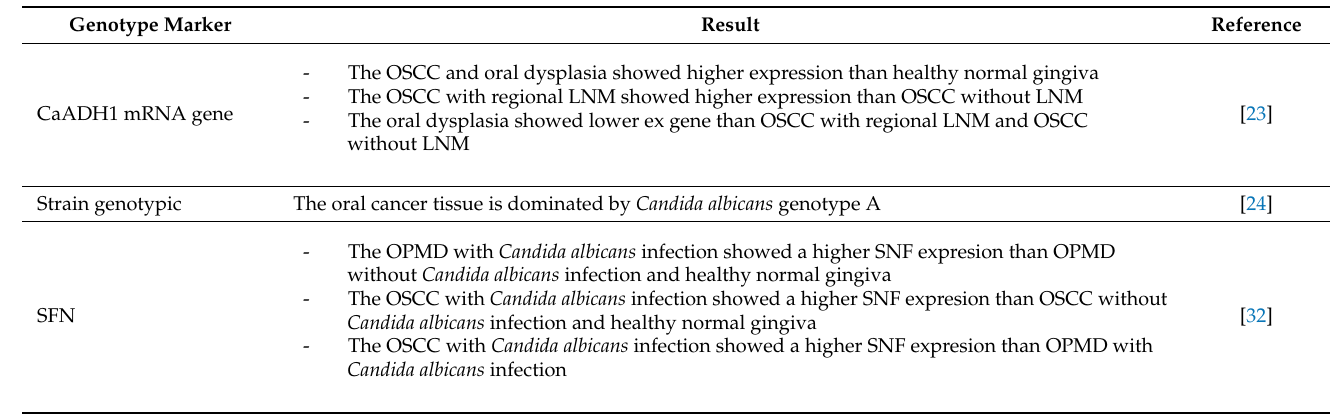
Table 4. The Candida albicans genotype identified in each lesion.